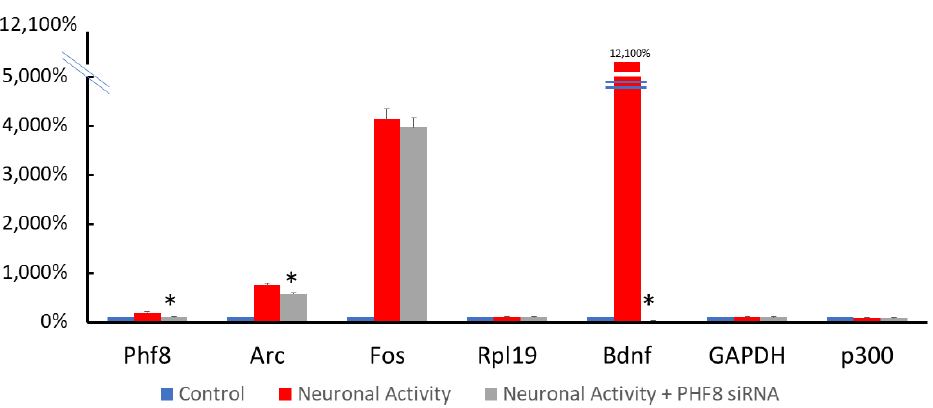
Figure 2. Knockdown of PHF8 transcription via RNA interference using small interfering RNA (siRNA)—values of 2 − delta(delta CT) normalized to a ribosomal gene Rpl19 in cortical neurons, which are quiescent (control) compared to neurons subjected to 3 h of 4AP + Bicuculline + Forskolin (4BF) with and without PHF8 siRNA, showing effective knockdown of the expression of PHF8 at 3 weeks (DIV 21) on neuronal and glial markers. Data are represented as mean ± SEM. All differences that are significant with a * p -value of <0.05 (Student’s two-tailed t -test) were marked with an